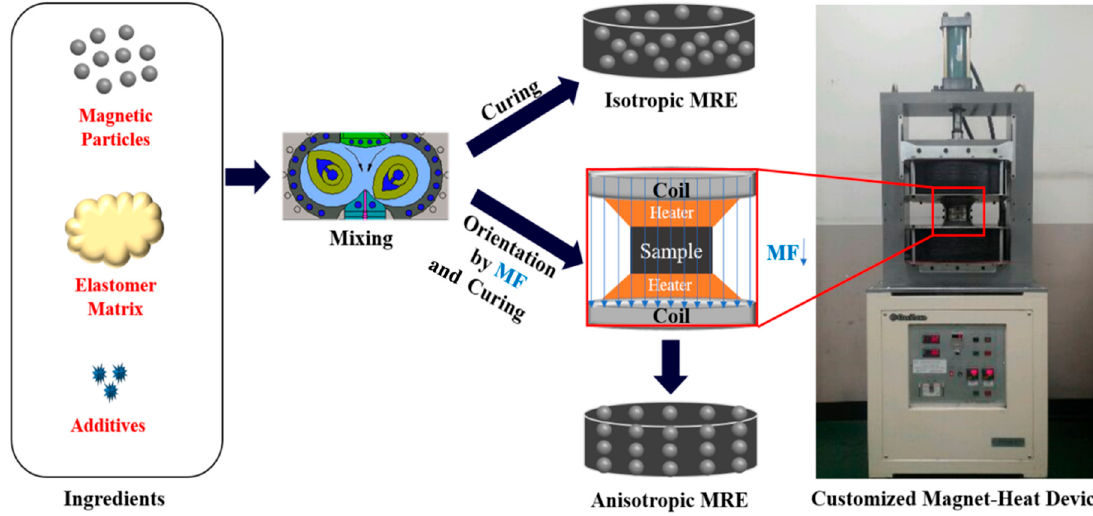
Figure 1. Schematic diagram of fabrication process of isotropic and anisotropic magnetorheological elastomers (MRE).